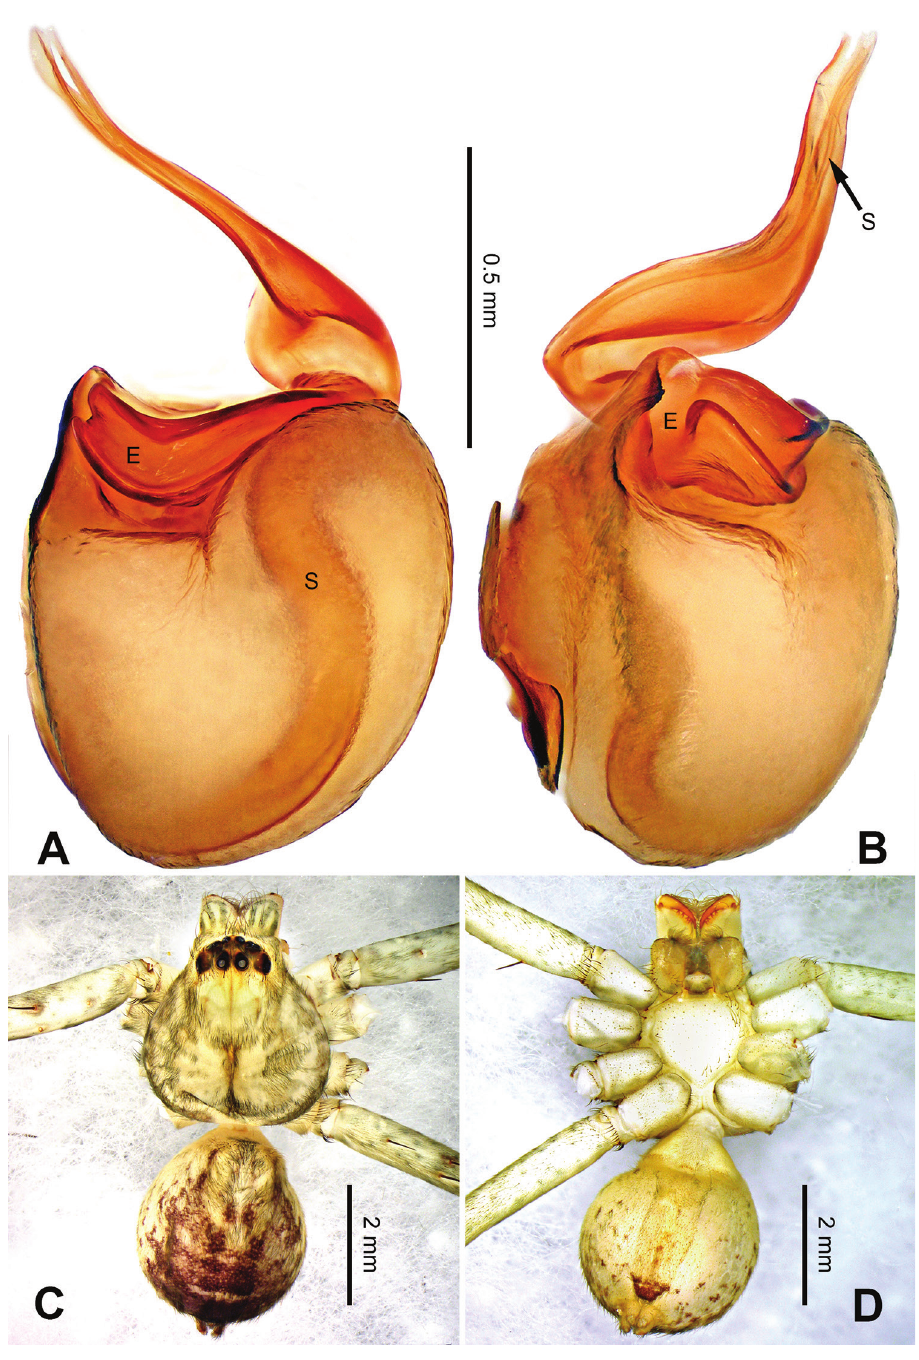
Figure 4. Pseudopoda colubrina Zhao & Li, sp. n., male holotype. A Bulb, ventral view B Bulb, dorsal view C Habitus, dorsal view D Habitus, ventral view. Scale bar equal for A,